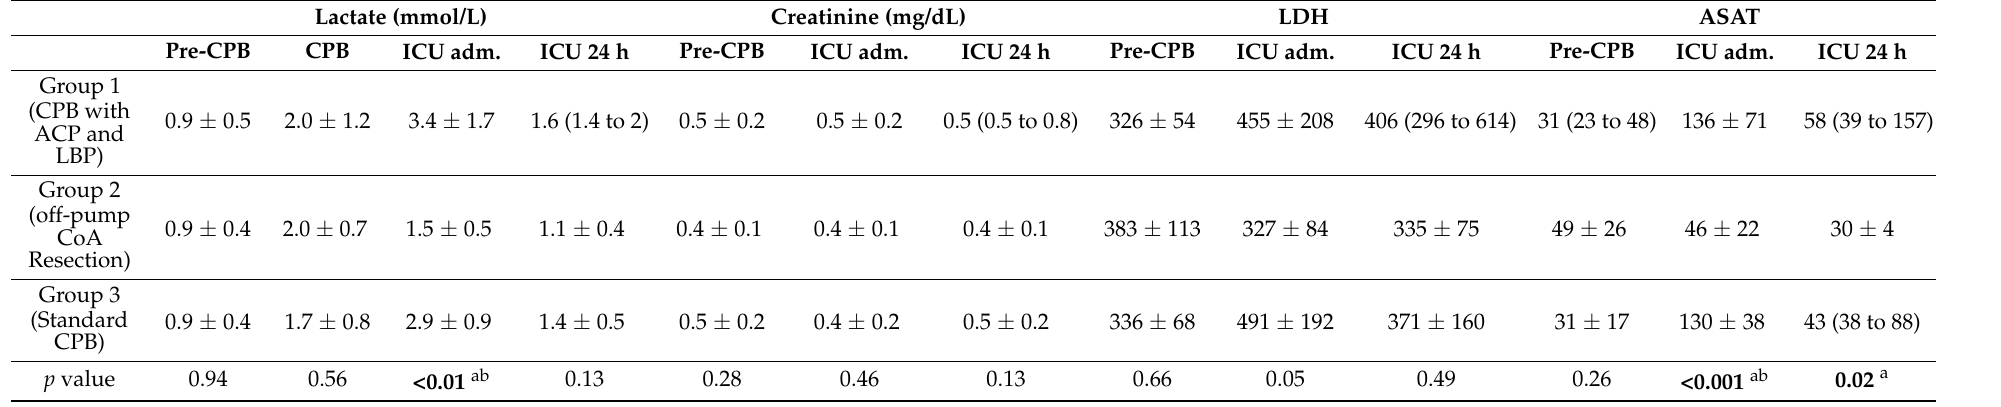
Table 2. Laboratory